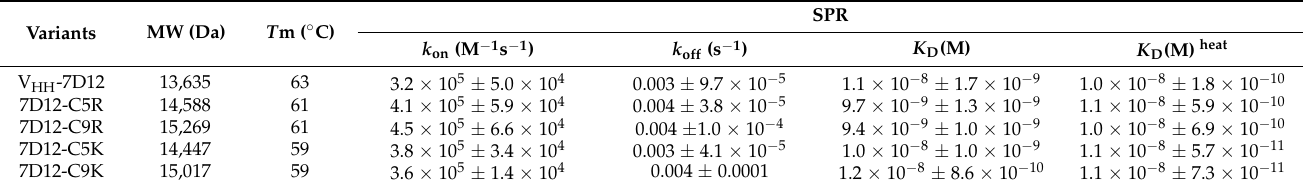
Table 1. Midpoint unfolding temperature ( T m) and binding affinity at 20 ◦ C of V HH -7D12